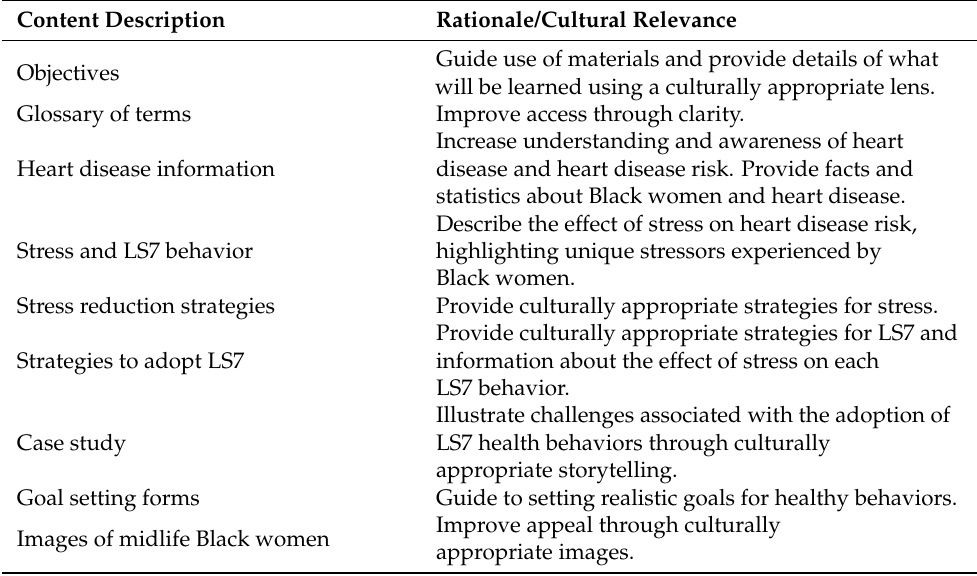
Table 2. Modular content and